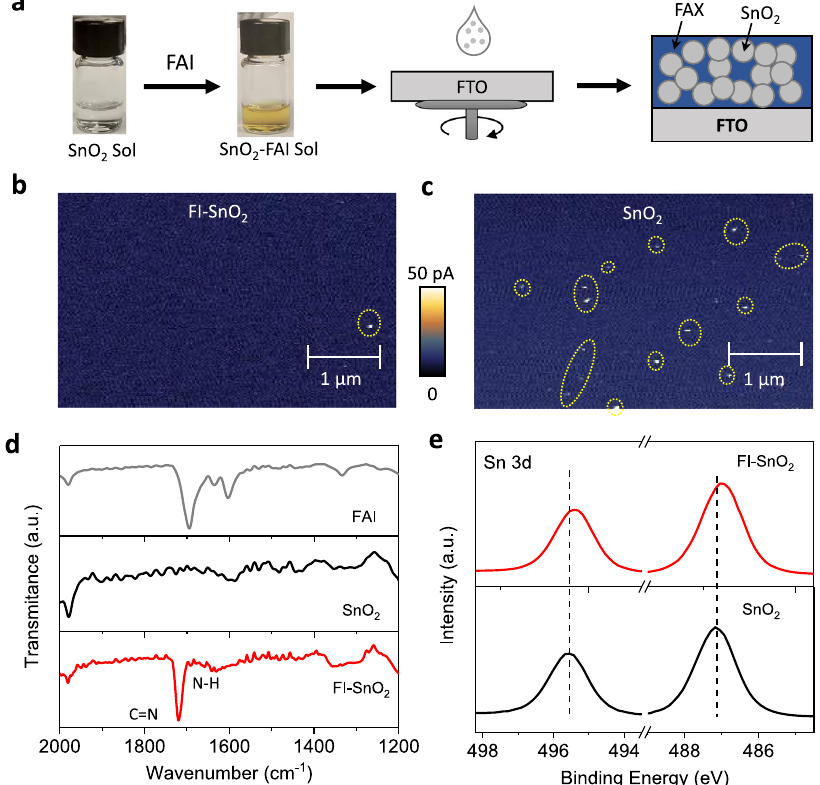
Fig. 1 ETL preparation and characterization. a Schematic illustration showing the synthesis process of FI – SnO 2 ETL. b , c C-AFM mapping of the FI – SnO 2 (left) and pristine SnO 2 (right) ETLs on FTO substrates. d FTIR spectra of FAI, SnO 2 , and FI – SnO 2 . e XPS spectra for Sn 3 d of FI – SnO 2 and pristine SnO 2